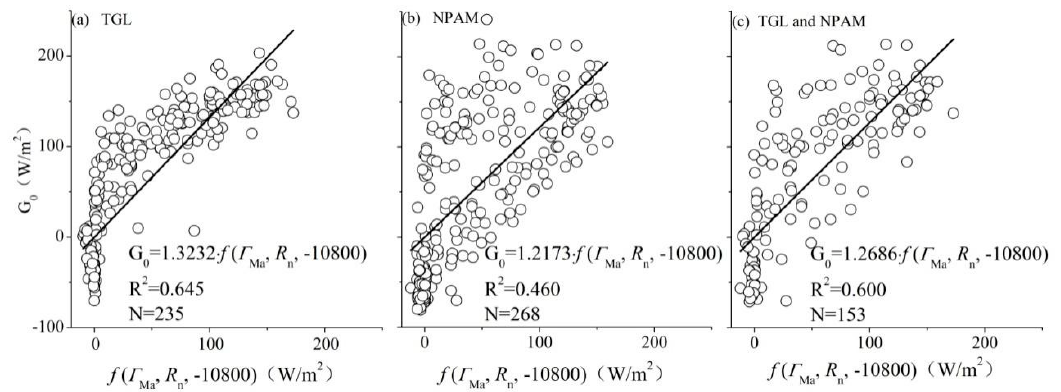
* TGL(77) represents the 77 samples of data from the TGL site included in the overall dataset when TGL and NPAM are taken as a whole.